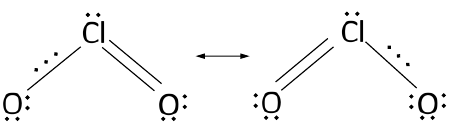
Figure 2. Electronic structure of the chlorine dioxide molecule.